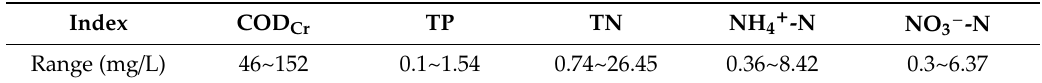
Table 1. Raw water quality of test water.